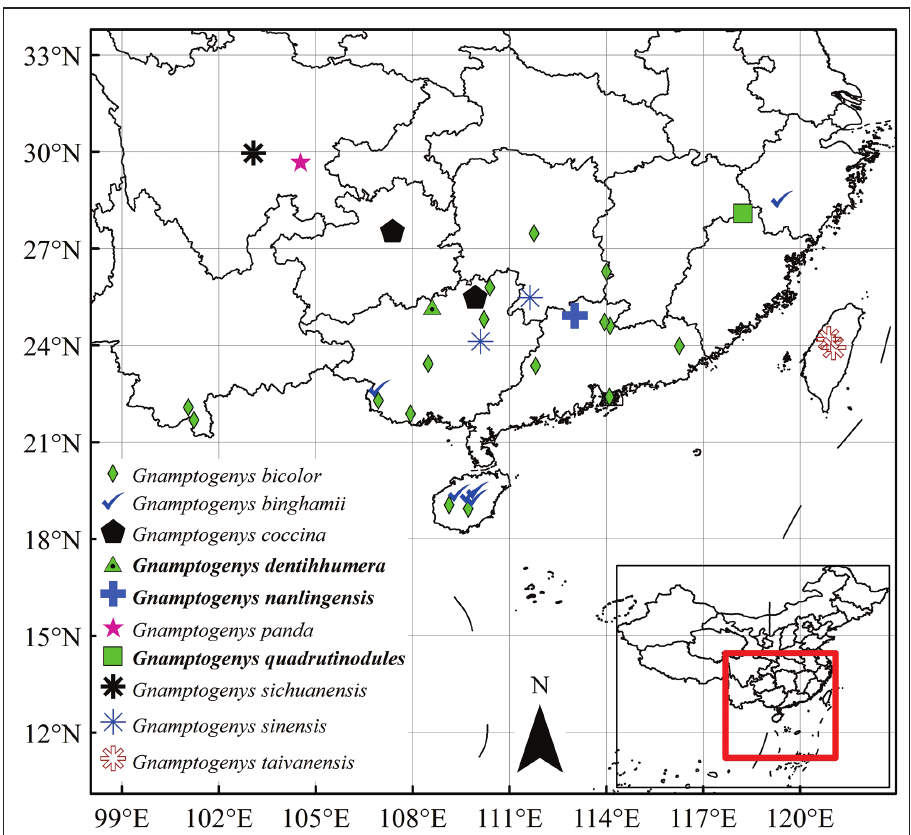
Map 1. Distribution of ten known species of the genus Gnamptogenys in China. The data came from collection specimens and